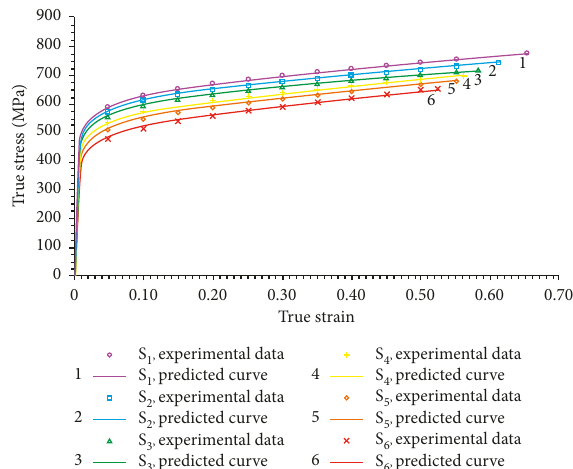
Figure 2: Comparison of elastic-plastic mixed-state model pre- dictions and experimental data for 304 stainless steel specimens